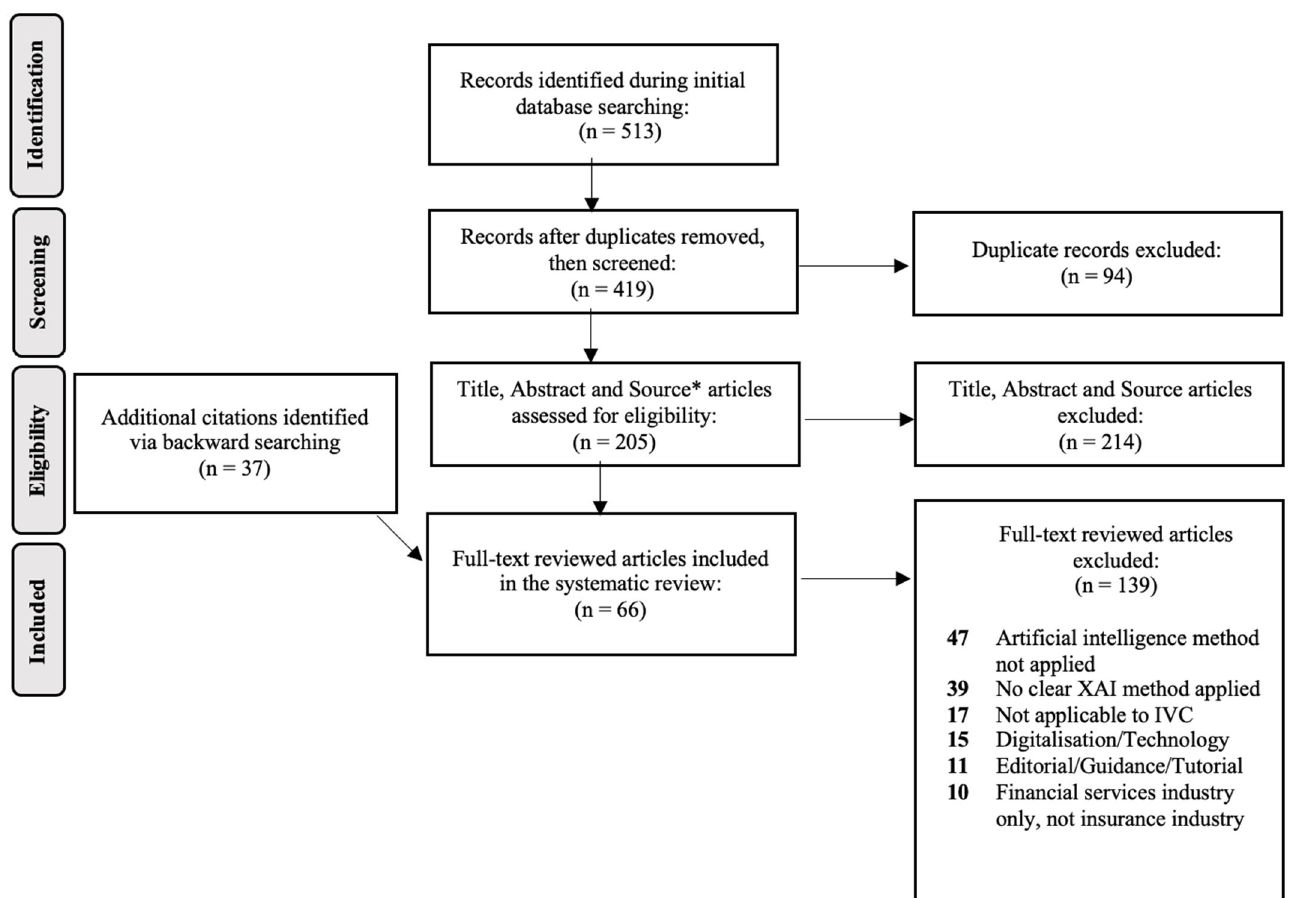
Figure 3. The PRISMA Flow Diagram is a recognised standard for systematic review literature search processes (Stovold et al. 2014). * ‘Source’ refers to the article inclusion criteria for this systematic review: journal articles and conference papers/proceedings are included. Table 4. AI Methods and XAI Criteria used for the systematic analysis of the